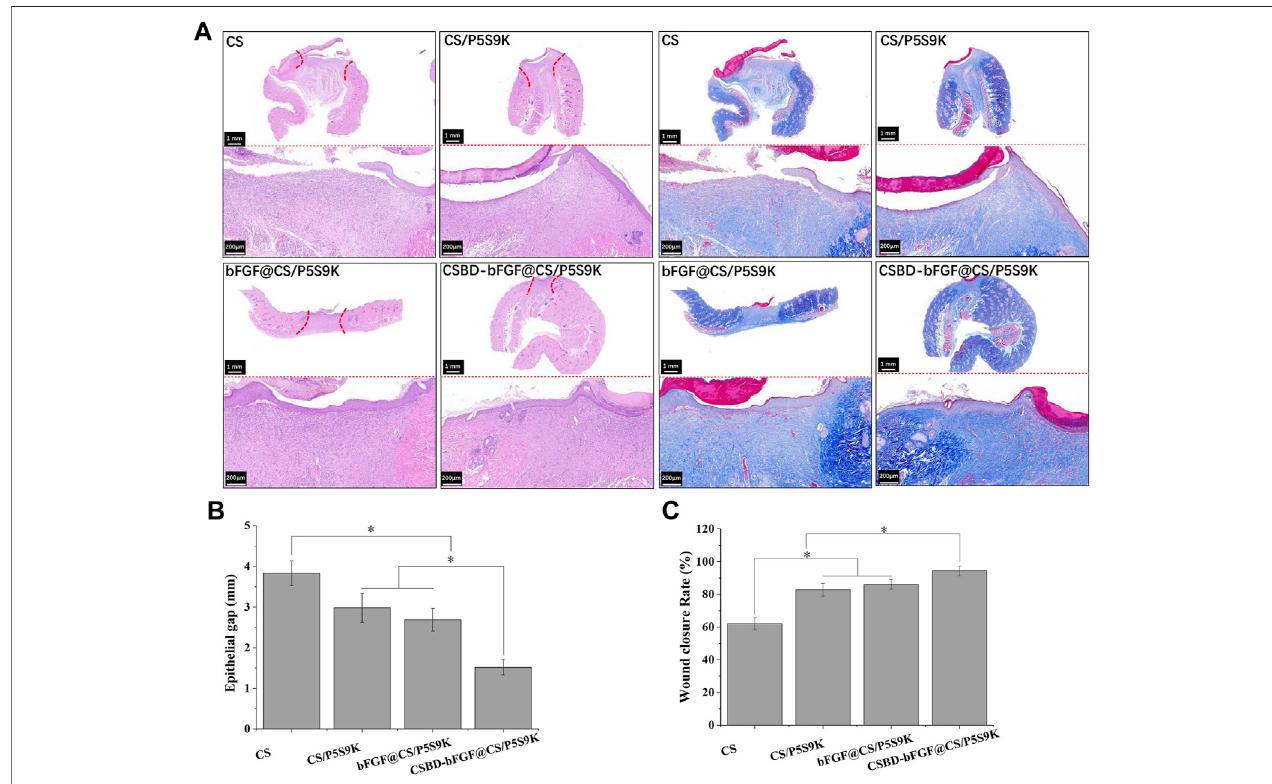
FIGURE9|(A) H&EandMasson ’ strichromestainingoftheskinatday12postoperation, (B) epithelialgap, (C) woundhealingrateatday12postoperation.Scale bars = 200 μ m, n = 3, p <